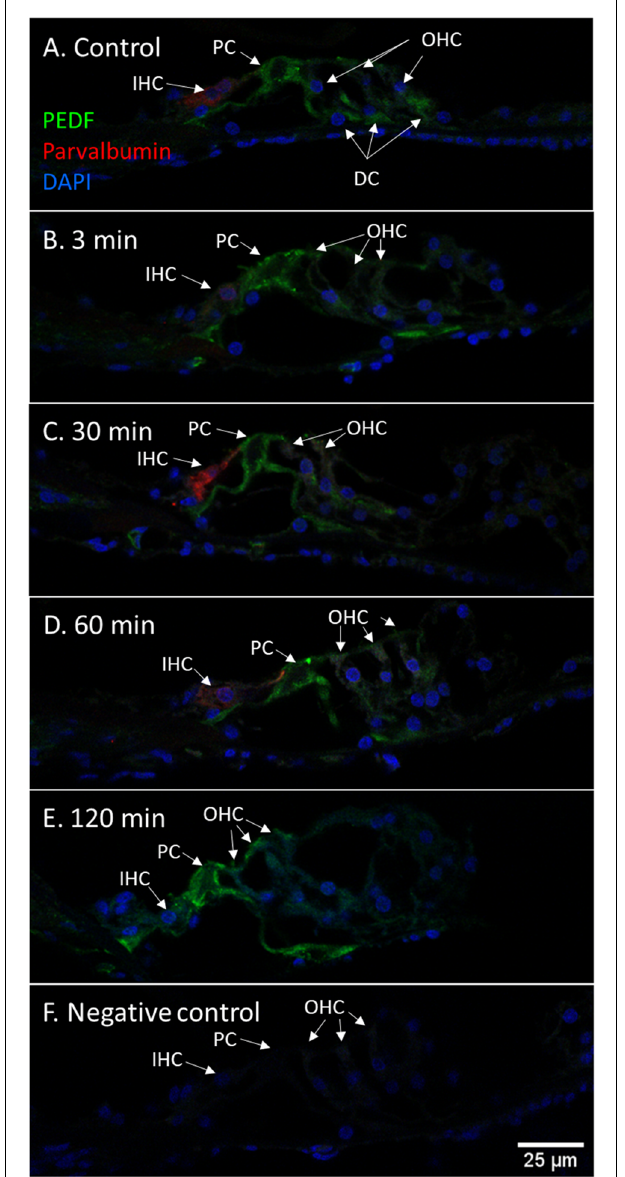
FIGURE 10 | PEDF in guinea pig organ of Corti following furosemide injection. (A–F) PEDF protein localization and staining intensity in the guinea pig’s organ of Corti following IV furosemide injection. Parvalbumin stains the IHC red. (A) PEDF was in the control detected in pillar cells and Deiters cells. (B–E) Staining intensity in the guinea pig’s organ of Corti following IV furosemide injection. (E) At 120 min staining increased in the pillar cells and the IHCs and OHCs stained for PEDF protein. (F) Negative control of organ of Corti.